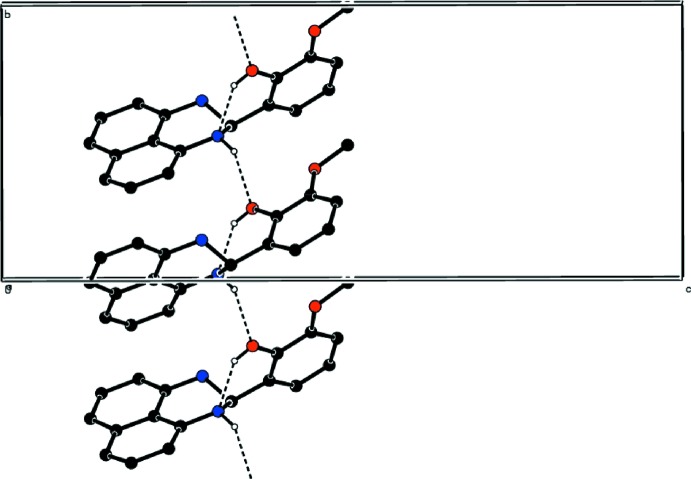
A partial packing diagram viewed along the a-axis direction with O—HPhnl⋯NPrmdn and N—HPrmdn⋯OPhnl (Phnl = phenol and Prmdn = perimidine) hydrogen bonds shown as dashed lines. H-atoms not included in hydrogen bonding have been omitted for clarity.